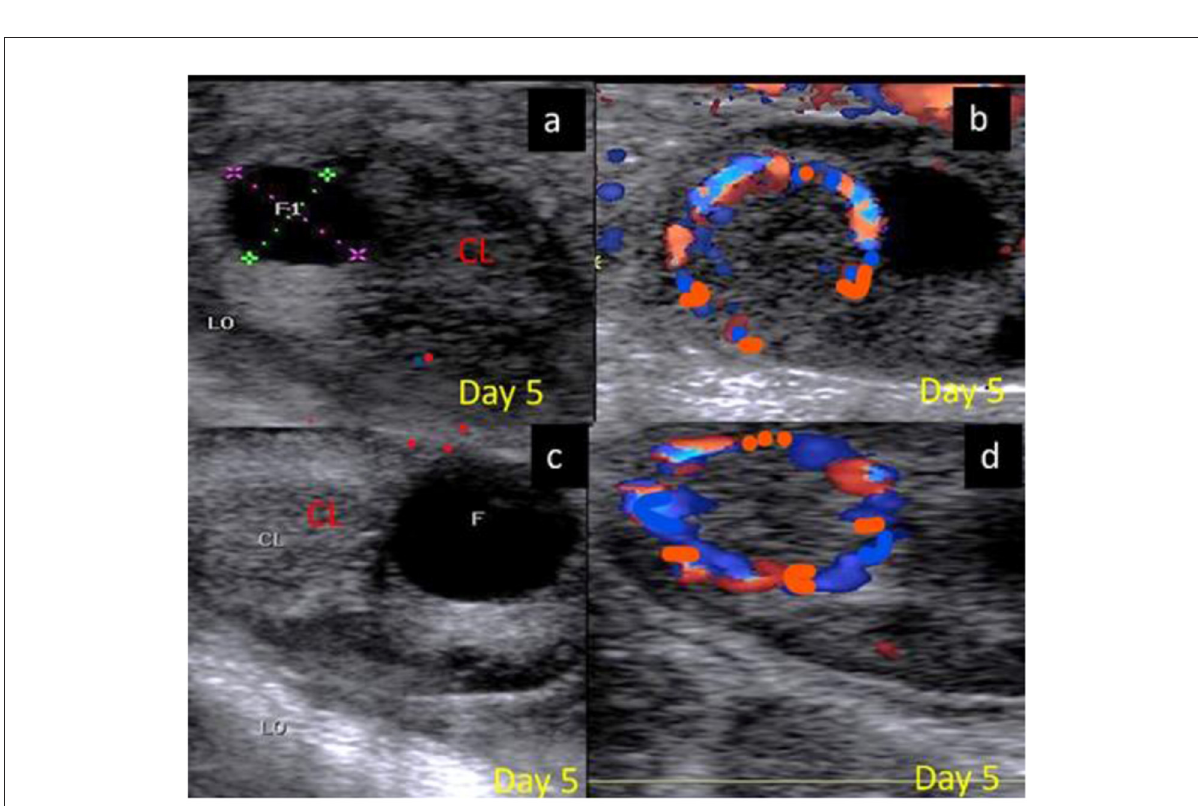
FIGURE4 B-mode and colored ultrasonograms of a 9-year-old buffalos at the early luteal phase (stage I; from 1 to 5 days) as (A,B) images showed an early formed corpus luteum in non-pregnant female on day 5 in gray and color modes and (C,D) images showed an early formed corpus luteum in suspected pregnant one on day 5 in gray and color modes. CL, corpus